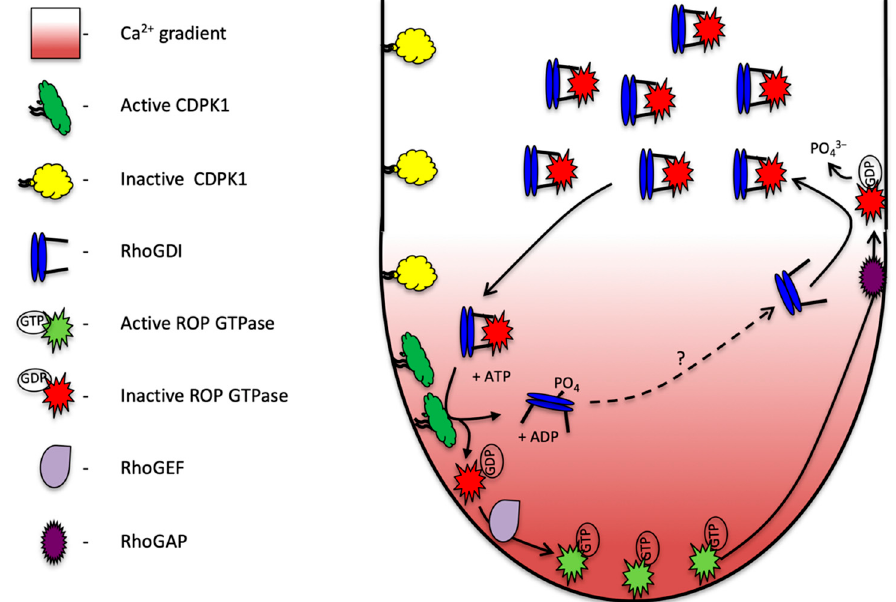
Figure 6. Proposed model of PiCDPK1 regulation of ROP in growing pollen tubes. Calcium- dependent protein kinase (PiCDPK1) is localized to the plasma membrane of the pollen tube. In the cytosol in the tube shank, Rho Guanine Dissociation Inhibitor (RhoGDI) binds to ROP GTPase removing to from the plasma membrane and locking it in an inactive state. At the tube tip, elevated calcium levels activate PiCDPK1, which phosphorylates the cytosolic RhoGDI:ROP GTPase com- plex. Upon phosphorylation ROP GTPase is released from the protein complex and recruited to the membrane where it is available for biological activation by Rho Guanine Exchange Factor (RhoGEF). Active (GTP bound) ROP GTPase interacts with and mediates the activity of downstream effectors to coordinate growth. As the tube extends, active ROP GTPase is passed back in the membrane until it interacts with ROP GTPase Activating Protein (RhoGAP), activating the enzyme activity of ROP causing it to hydrolyze GTP to GDP and become biologically inactivated. GDP bound ROP can be removed from the membrane by non-phosphorylated RhoGDI and recycled back to the tube tip. The dotted line and question mark indicate the activity of an as yet unidentified phosphatase the activity of which is needed to re-activate